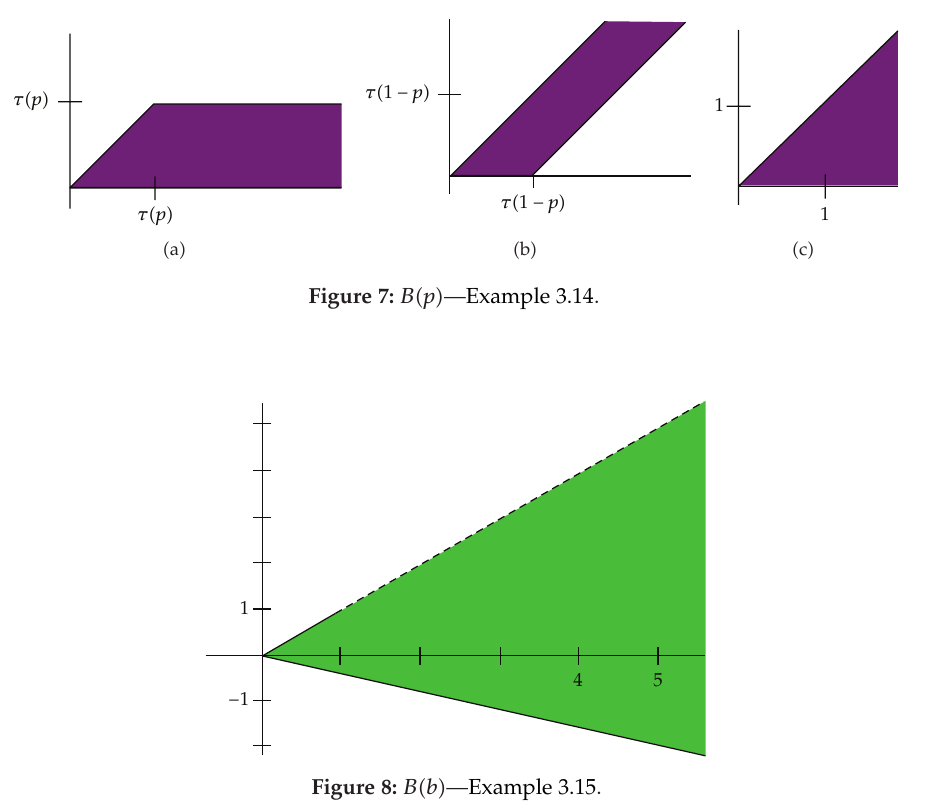
Figure 8: B (cid:2) b (cid:3) —Example